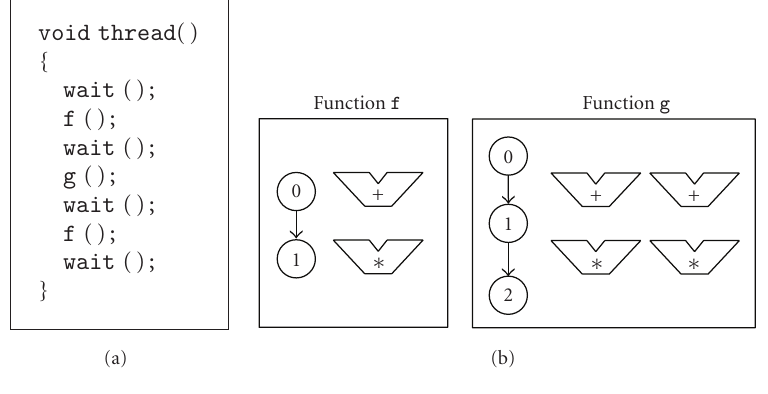
Figure 2: SystemC program calling two functions f and g .